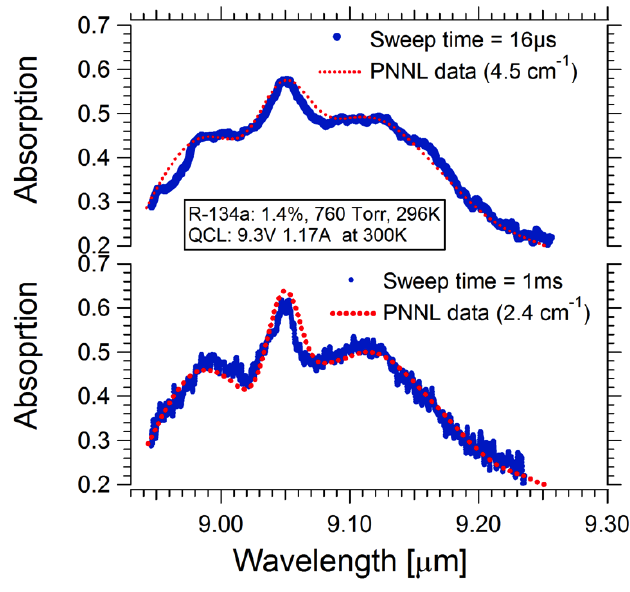
Figure 5. Comparison between R134a absorption spectra measured for fast (16 μs; top ) slow (1 ms; bottom ) sweep times.